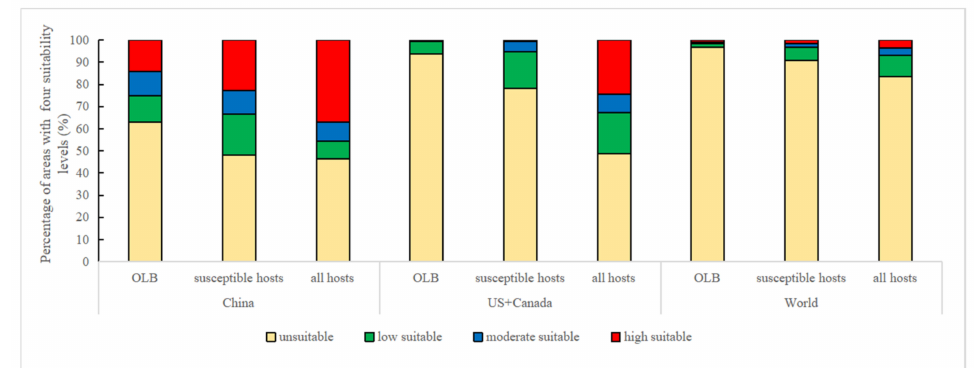
Figure 5. Percentage of areas of four suitability levels (unsuitability, low suitability, moderate suitability, and high suitability) for M. raddei (OLB), its two susceptible hosts ( Q. mongolica and Q. liaotungensis ) and all 11 hosts at three spatial ranges (China, US + Canada, the whole world) based on three Maxent model